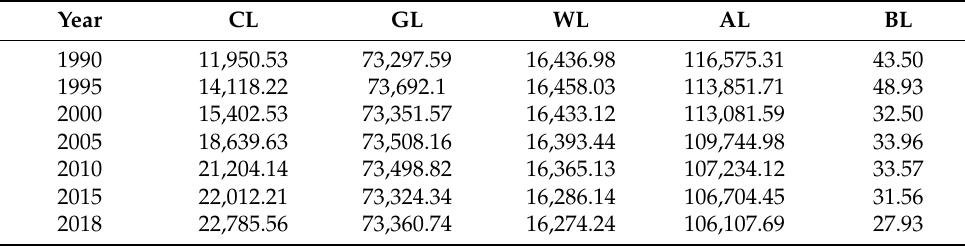
Figure 2. LUC result of the Yangtze River Delta from 1990–2018. Table 3. LUC classification data 1990–2018 ( Unit: km 2 ).